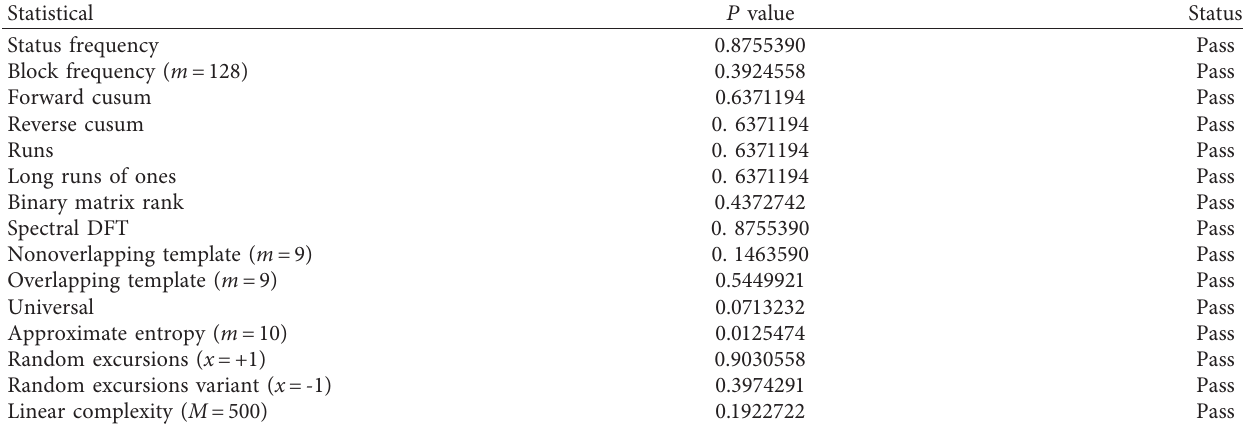
Table 10: Test results of the NIST 800-22 for the proposed PRNG.